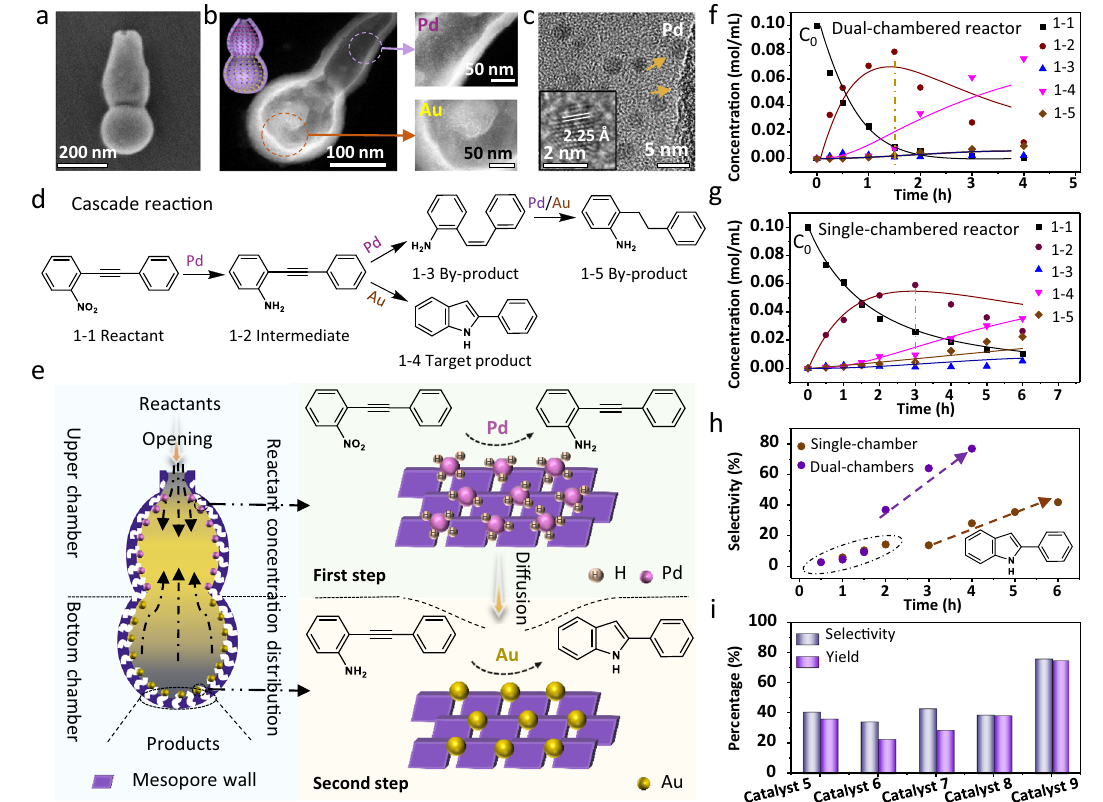
Fig. 5 | Dual-chambered mesoporous silica nanoreactors. a SEM, b HAADF- STEM,and c high-resolutionTEM(HRTEM)imagesoftheobtaineddual-chambered mesoporous silica nanoreactors by selectively loading Au and Pd nanocrystals in the bottom and upper cavities of reactors, respectively. The inset in b is the 3D structural model and inset in c is the HRTEM image of the Pd nanocrystals. d Schematic illustration, e concentration distribution of reactants, and f kinetic plotsofthecascadereactioninthedual-chamberednanoreactor(Auinthebottom chamber, Pd in the upper chamber). g Kinetic plots of the cascade reaction in the single-chambered nanoreactor (Au and Pd loaded in the same chamber). h The